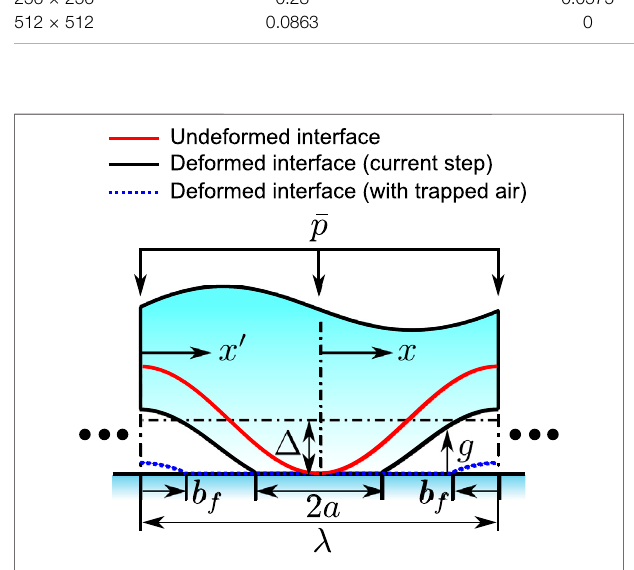
FIGURE 7 | Schematic of sinusoidal wavy surface in purely normal contact with a rigid fl at .